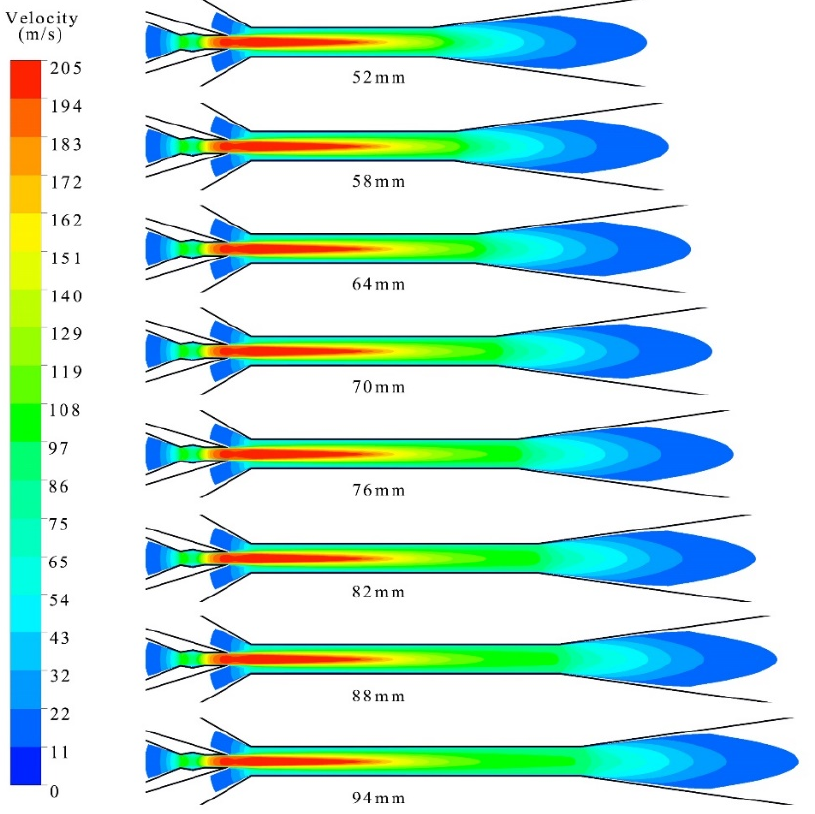
Figure 12. Fields of velocity under different L m ( P p of 9.3